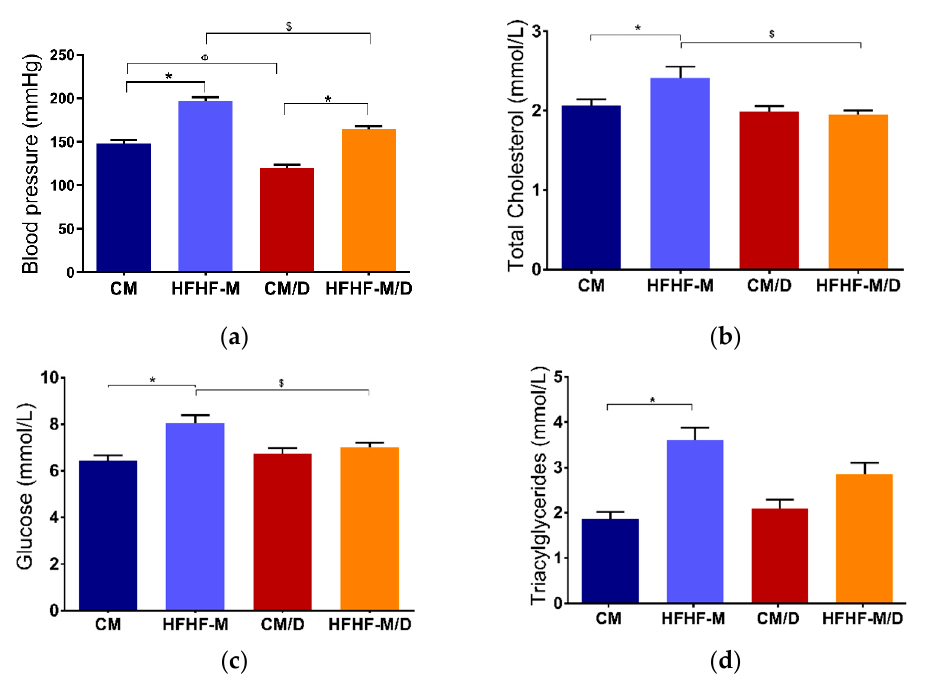
Figure 6. Effect after 14 days of compound 1b administration on metabolic parameters associated to MetS on the in vivo model ( a ) Blood Pressure ( b ) Cholesterol, ( c ) Glucose, ( d ) Triacylglycerides. After 14 days of treatment with compound 1b , the HFHF-M/D group had a statistically significant reduction of blood pressure, total cholesterol, and glucose compared to the HFHF-M group. Also, the HFHF-M/D group observed a non-statistically reduction of the triacylglycerides compared to the HFHF-M group, but also a non-statistical significant difference was observed to CM and CM/D groups. Data are presented as means ± standard deviation (SD). * Represents statistically significant differences between groups compared to their own control group (CM vs HFHF-M) (CM/D vs HFHF-M/D) ( p < 0.05). ɸ Represents statistically significant differences between CM vs CM/D ( p < 0.05). $ Represents statistically significant differences between HFHF-M vs HFHF-M/D ( p < 0.05).